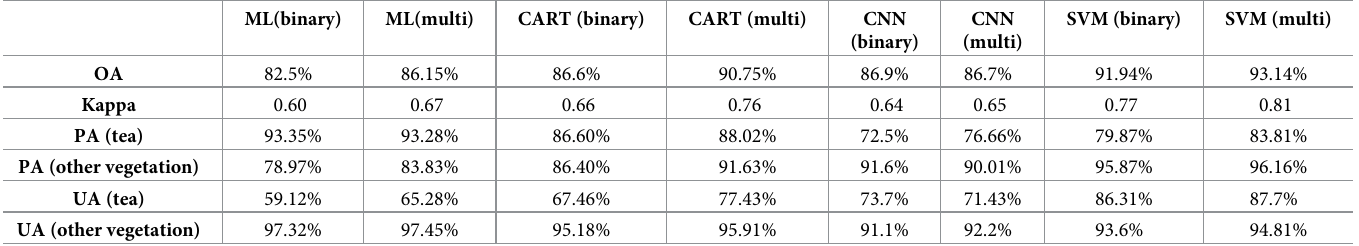
Table 9. Accuracy assessment of 2017 binary classification and multi-classification result (OA(Overall accuracy), PA(Producer accuracy), UA(User accuracy), ML (Maximum